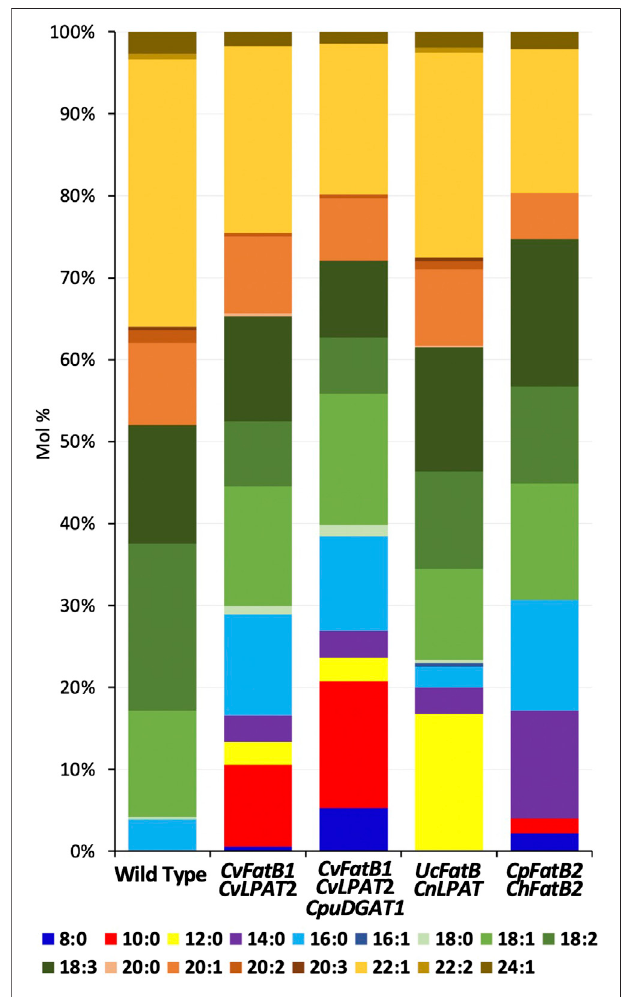
FIGURE 1 | Fatty acid (FA) compositions of seed TAGs of transgenic lines harboring one of the four MCFA biosynthetic gene combinations. Shown are data from the lines having the highest MCFA accumulation. Average FA mol% amounts along with standard deviations are shown in Table 1